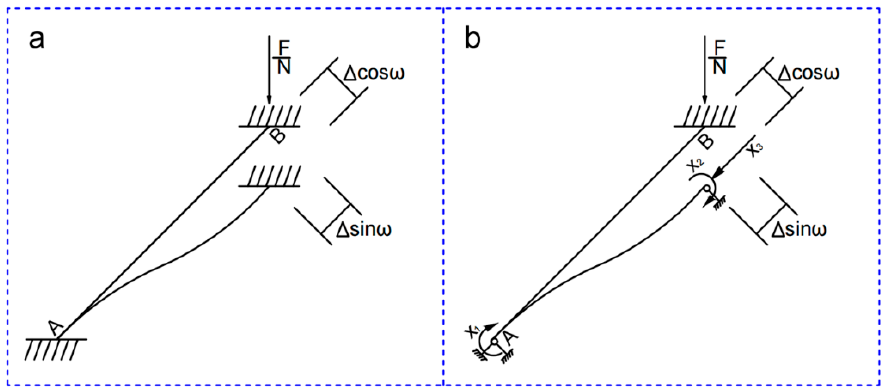
Figure 5. The force method of ( a ) the basic structure and ( b ) the basic system.